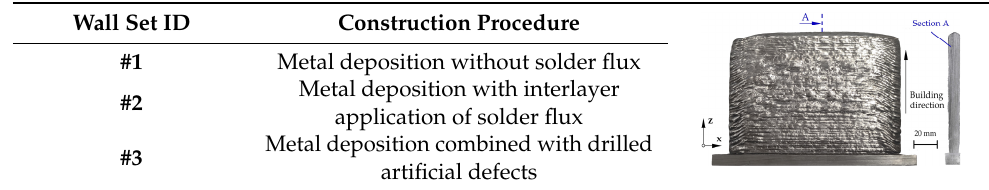
Table 3. Construction procedures for the three different sets of WAAM aluminum straight walls used in the experimental